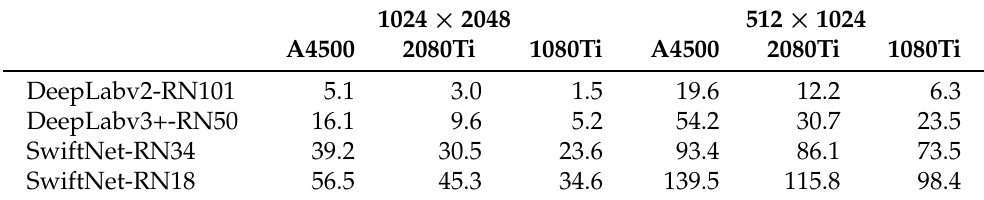
Table A5. Model inference speed (number of iterations per second) on three different GPUs and two input resolutions. Inputs are processed one by one, without overlap in computation. The measurements include the computation of the cross-entropy loss, but do not include data loading and preparation.